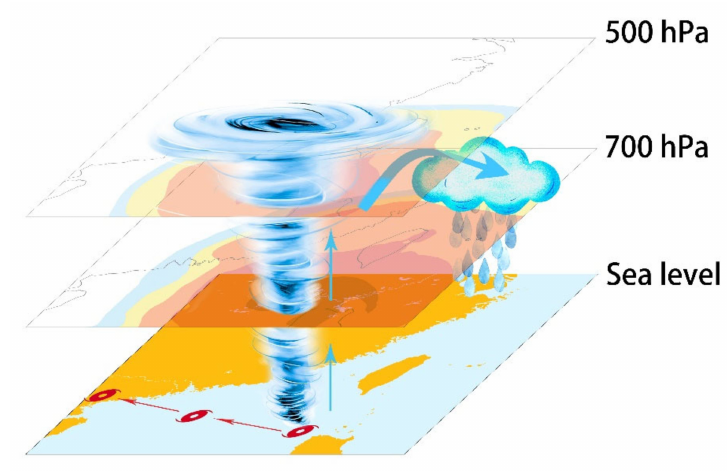
Figure 8. Conceptual diagram of water vapor